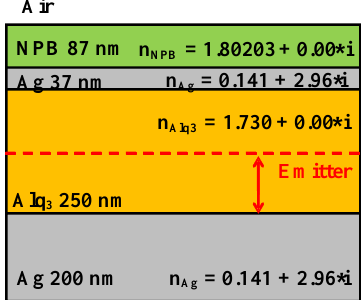
Figure 2. Device structure of a top-emitting OLED along with the corresponding layer thickness and complex refractive index. To simplify the calculation, both exciton generation and carrier transport are assumed to occur at the Alq 3 EML layer. The dipole emitter with the wavelength of 520 nm is assumed to be isotropic and to have the δ-distributed emission zone, which is positioned z ex away from the interface between the reflective bottom anode and EML.